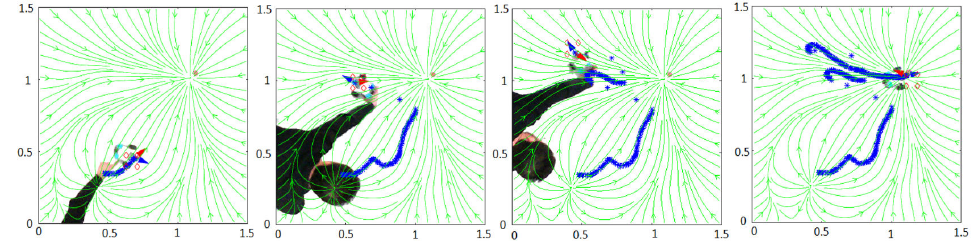
Figure 4. PGD path planner. The red goal is changed in real